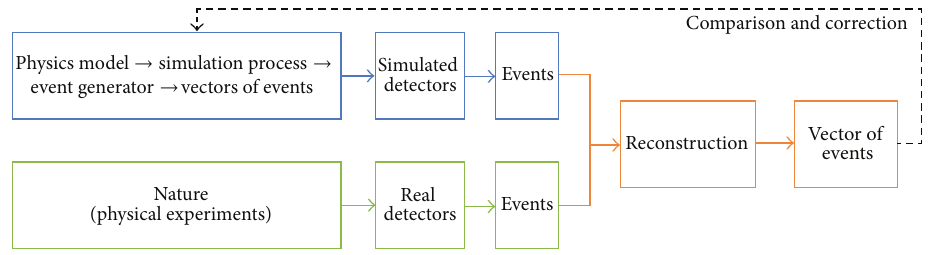
Figure 1: General approach of event generation, detection, and